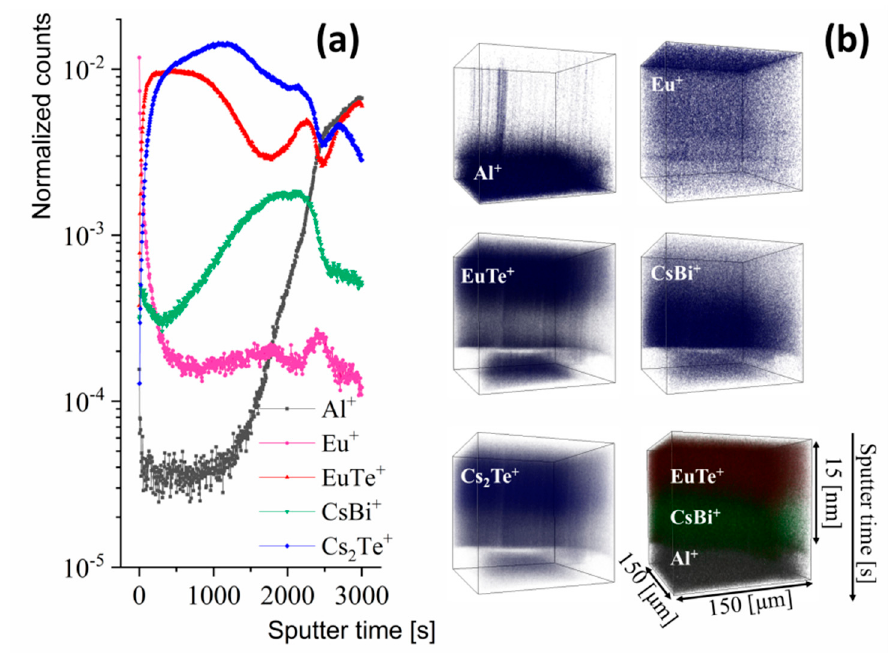
Figure 6. TOF-SIMS depth profiles of Eu doped Bi2Te3 films. Linear profile of film components ( a ), and 3D depth profiles ( b ) for selected secondary ions.